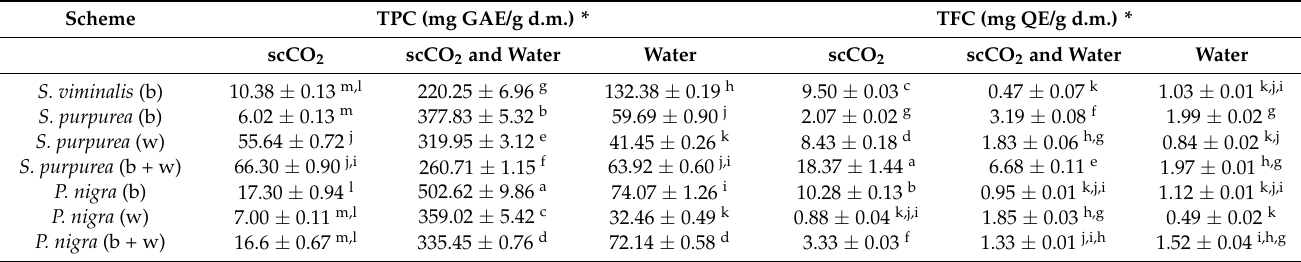
Table 1. Total polyphenol (TPC) and flavonoid (TFC) content in extracts obtained using: scCO 2 , scCO 2 and water or water. Scheme TPC (mg GAE/g d.m.) * TFC (mg QE/g d.m.) * scCO 2 scCO 2 and Water Water scCO 2 scCO 2 and Water